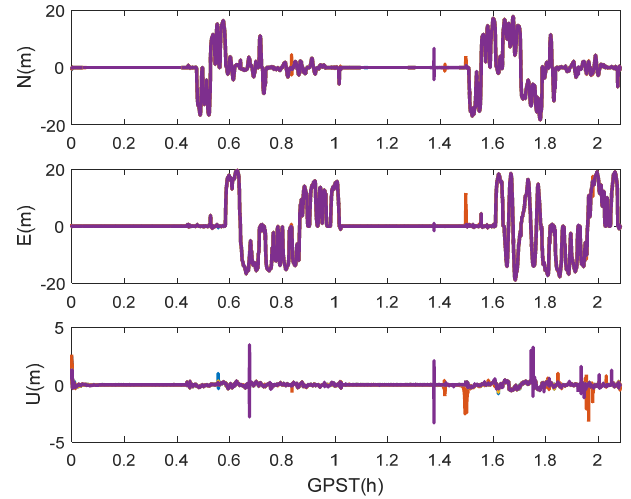
Figure 3. Coordinate increments in the following directions: north, east and up.